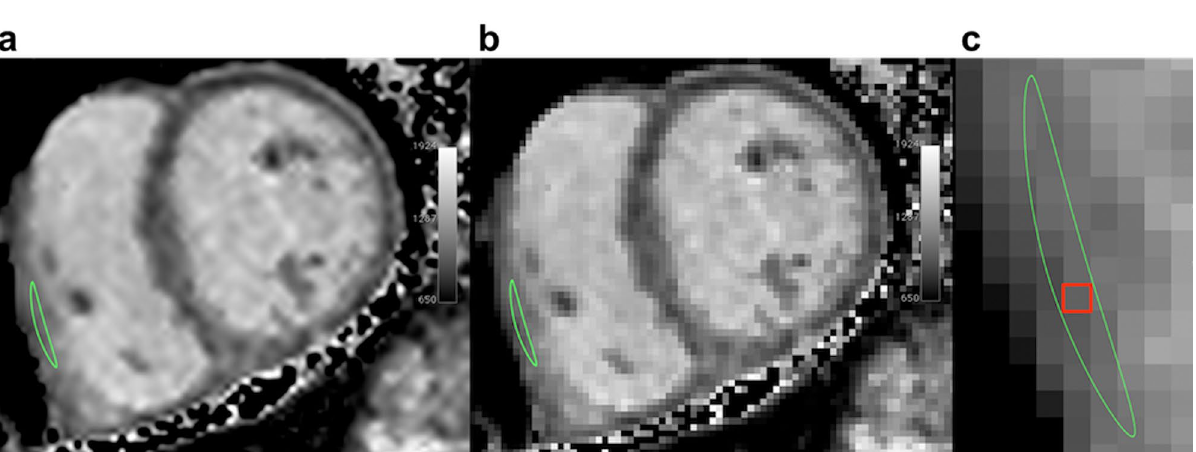
Figure 1. Grades of image quality. Native (panel a ) and post-contrast T1 maps (panels b + c ) with image quality rated as a : excellent (score grade 1) in a 39-year-old patient with repaired tetralogy of Fallot; b : sufficient (score grade 2) in a 37-year-old patient with d-transposition of the great arteries post atrial redirection with the Senning procedure; c : poor (score grade 3) in a 23-year-old patient with univentricular heart post Fontan palliation. Definitions of grades 1–3 are given in Table 1. Images were created using OsiriX Lite (v.12.0.0, https :// www.osiri x-viewe r.com/).